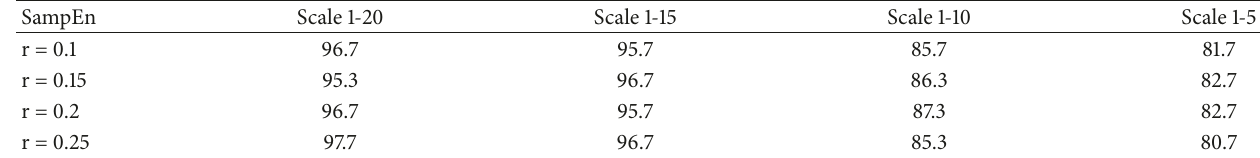
Table 2: Accuracy (%) using quadratic SVM and 5-fold CV.